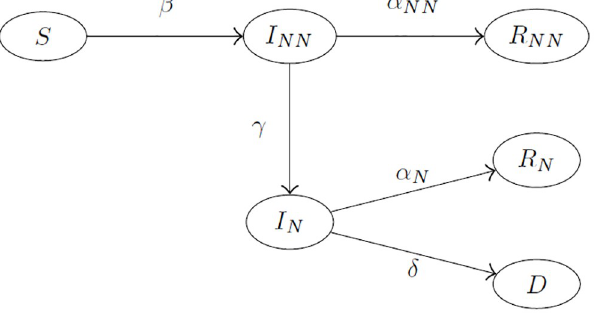
Fig 1. Admitted transitions between compartments of the SI 2 R 2 D model with the corresponding transition parameters.